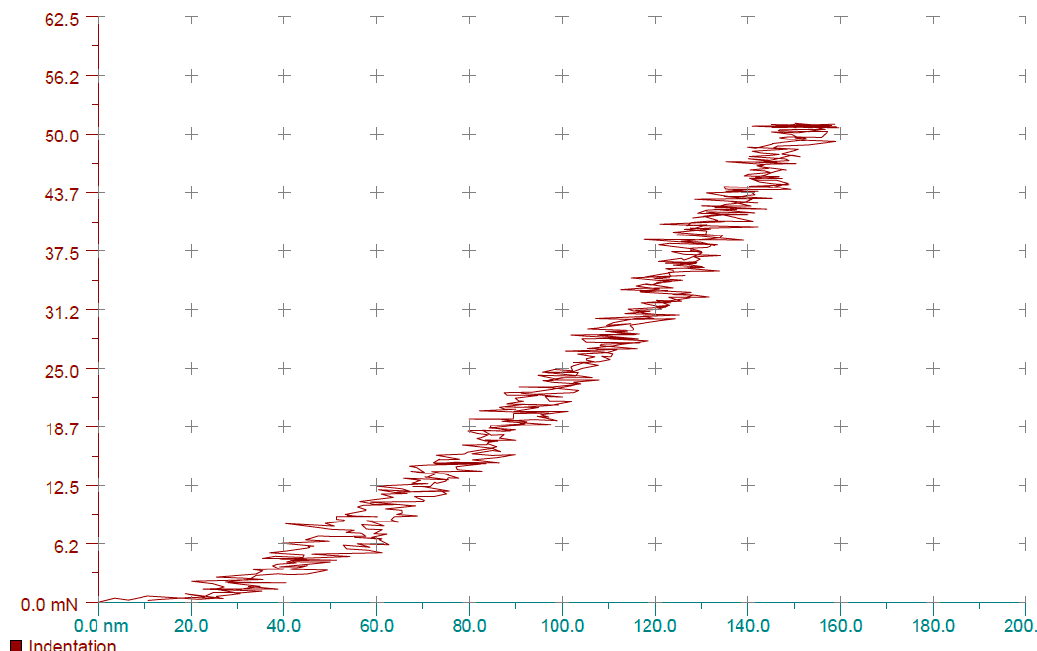
Figure 9. EDS analysis of Sample 2.